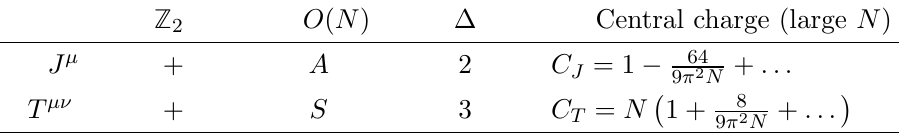
Table 1 . Top: representations and one-loop dimensions of low-lying operators in the 3D GNY models. V , S , T , A denote the vector, singlet, rank-two traceless symmetric tensor, and rank-two antisymmetric tensor representations of O ( N ), respectively. At large N , the dimensions of i was computed in [14{16], while the dimension of was computed in appendix B of [13]. We list no ( i j ) corrections for dimension of the lowest operator in the O ( N ) anti-symmetric representation, as we could not (cid:12)nd any discussion of it in the literature. The most recent (cid:15) -expansion estimates for the scaling dimensions are available in [33], where O ( (cid:15) 3 ) corrections are available for the dimensions associated to i and (cid:30) . Prior work on the (cid:15) -expansion for the GNY models can be found in [28{33]. Bottom: representations and one-loop values for the central charges for the O ( N ) conserved current and for the stress-energy tensor at large N as determined in